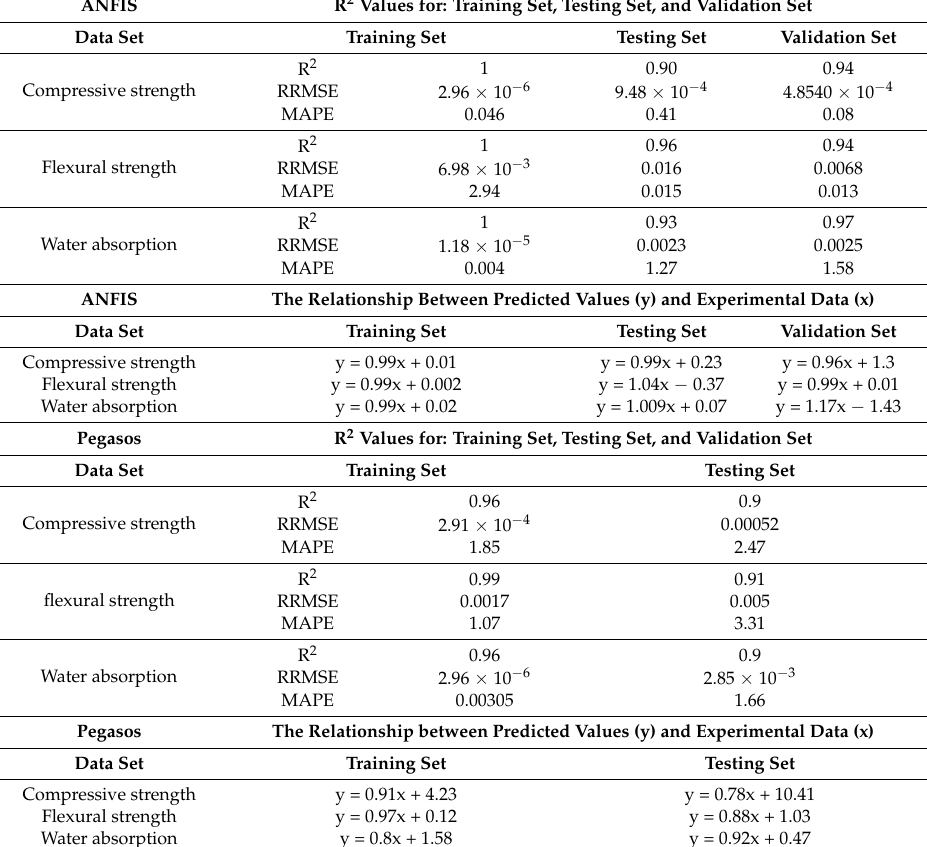
Table 5. Adaptive neuro-fuzzy inference system (ANFIS) and Primal Estimated sub-GrAdient Solver for SVM (Pegasos) results. ANFIS R 2 Values for: Training Set, Testing Set, and Validation